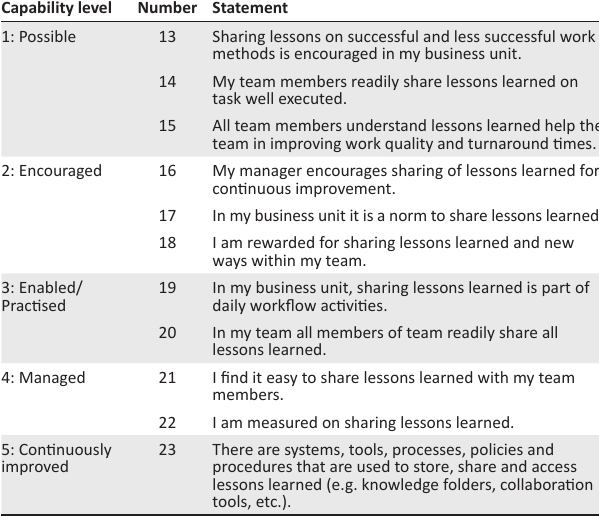
TABLE 2-A1: Question 7: Lessons learned. Capability level Number Statement